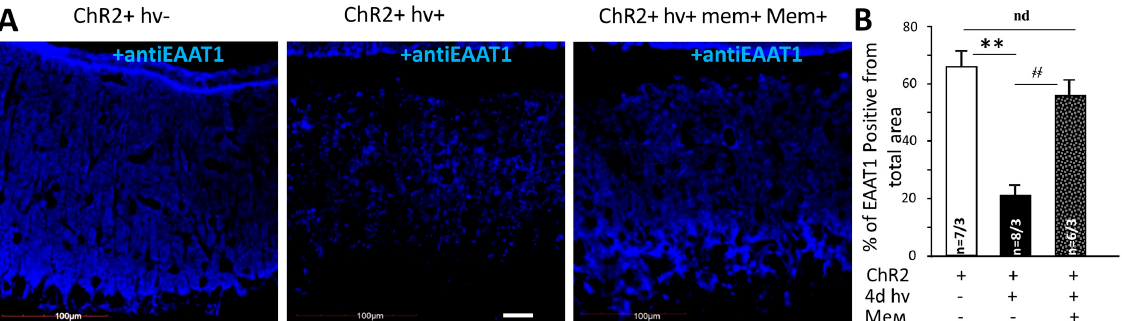
Figure 5. EAAT1 expression in reactive BGChR2+ and influence of memantine to this expression. ( A ) Confocal images of BG ChR2+ processes without (ChR2+ hv-) and after 4 days photostimulation (ChR2+ hv+) combined with oral administration of memantine (ChR2+ hv+ mem+). EAAT1 is labeled with blue color. Scale bar 20 μ m. ( B ) The averaged surface of the EAAT1 positive elements in relation to the total area. ** p < 0.01; ҂҂ p < 0.01.